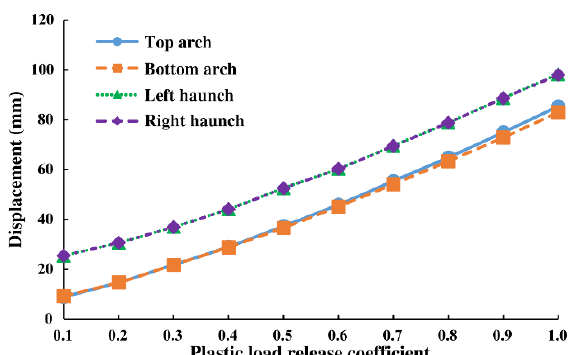
Figure 9. Displacement variation with plastic load release coefficient of type V surrounding rock.